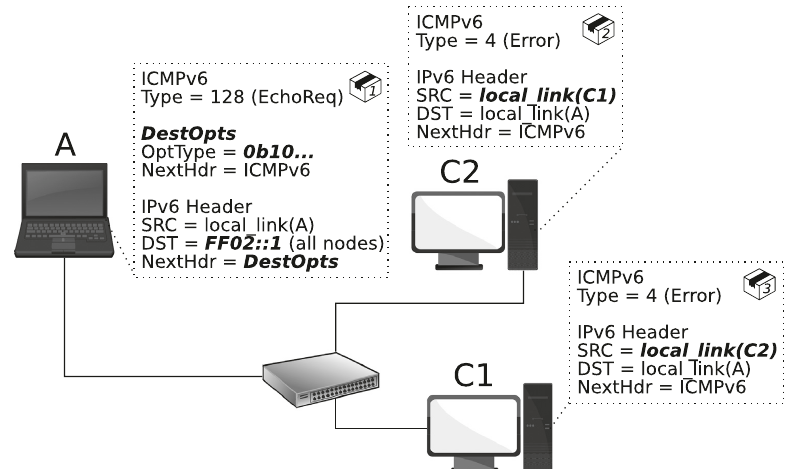
Figure 3: IPv6 multicast alive scan.